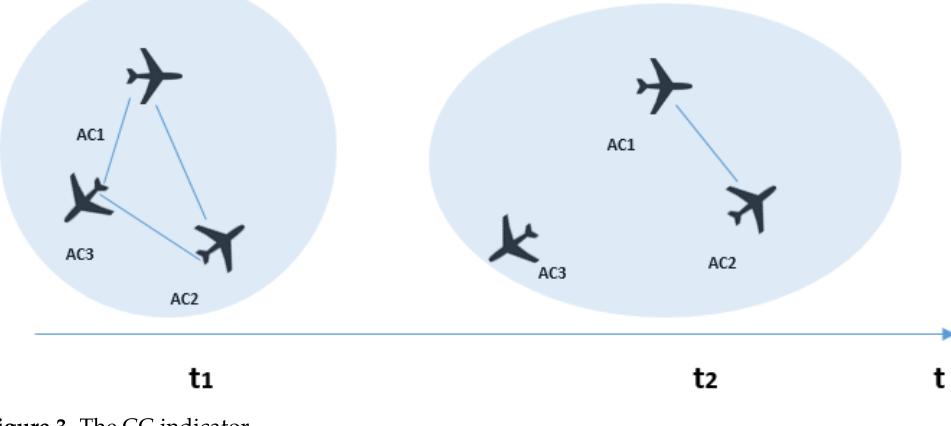
Figure 3. The CC